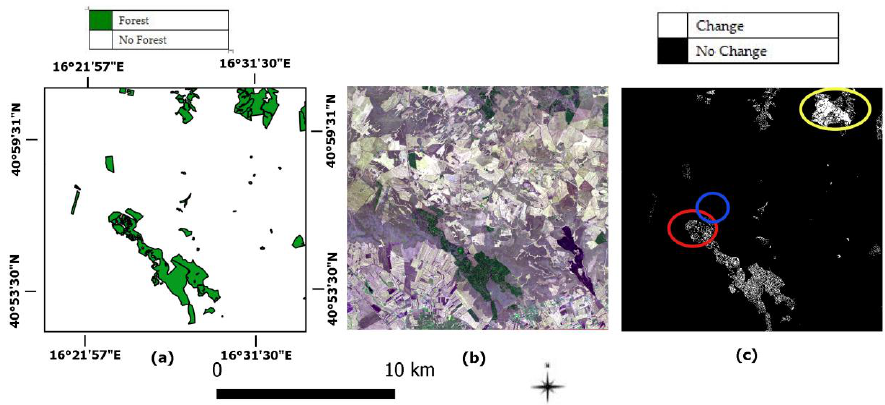
Figure 7 Figure 7. Experiment 2.b—CCA_VHR, Italian site: ( a ) forest layer from LC/LU map, including needle leaved, broadleaved and mixed forests (T 1 = 2006); ( b ) Worldview-2 image, 6 July 2012, RGB: Red–Nir–Blue (T 2 ); and ( c ) change map obtained by CCA_VHR, with TH = µ + 1 σ .